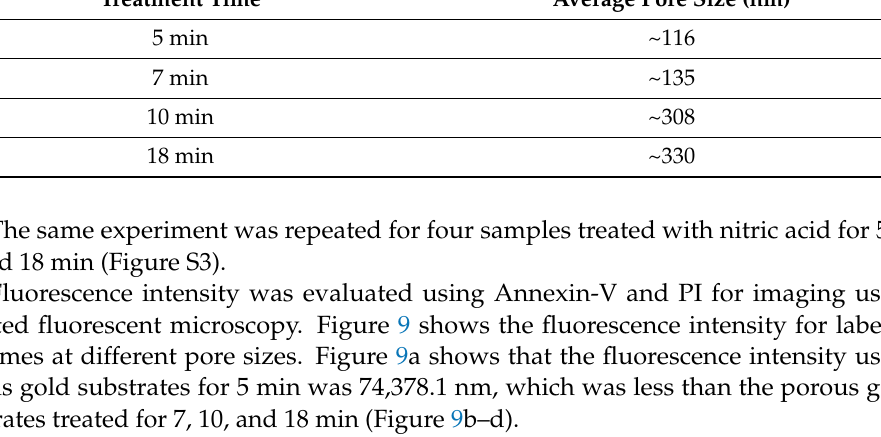
Table 2. Different treatment times vs. different pore sizes. Treatment Time